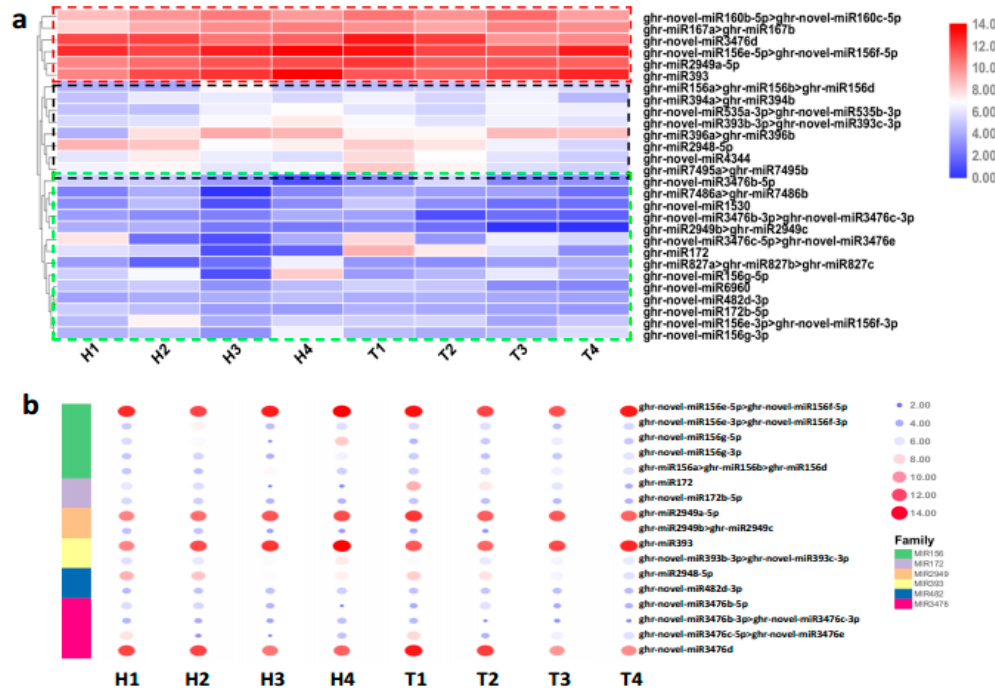
Figure 2. Differential expression of miRNAs at the four stages of anther development under HT stress. ( a ) Heatmap of the 28 differentially expressed miRNAs responding to HT stress. miRNAs in red-, black-, and green-dotted boxes have high, medium, and low expression levels, respectively. ( b ) Heatmap of six major miRNA families responding to HT stress.